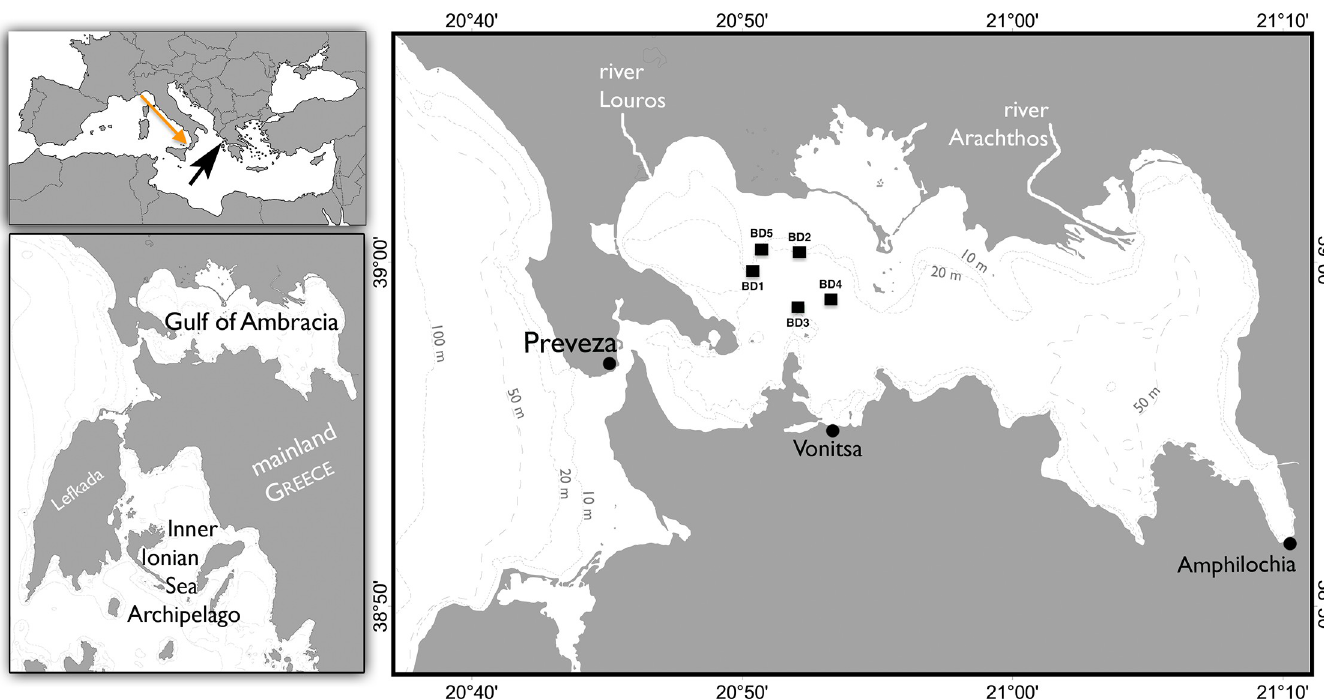
Fig 2. Maps of the Gulf of Ambracia. Geographic origin of wild bottlenose dolphins and sperm whale sampled during the study. Orange arrow: sampling site for the sperm whale in the Thyrrhenian Sea. Black arrow: geographical localization of The Gulf of Ambracia. The Gulf is a shallow, semi-closed embayment of 405 km 2 whose only communication with the open Ionian Sea is through the Preveza Channel, a narrow (minimum width of 370m) and shallow (2–12 m deep) 3 km-long corridor. Right map: Blows correspond to Table 1 IDs.